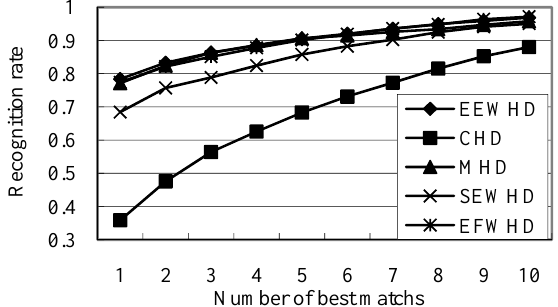
Fig. 7 Comparison of average accumulative recognition rate using different training set EEWHD outperforms other Hausdorff